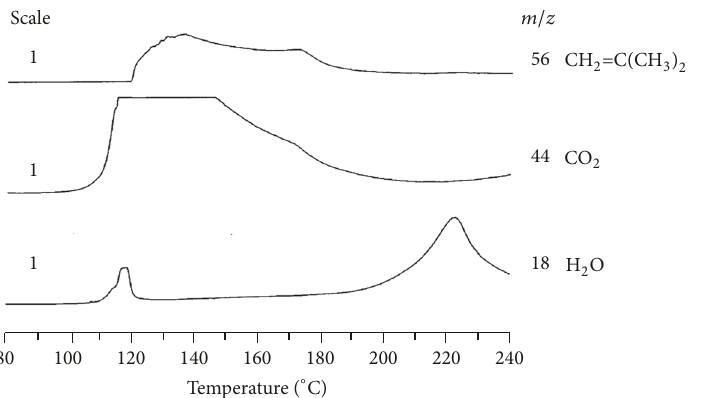
Figure 6: Thermal release patterns of ions for compounds from Boc-L-Asp ( 5a ) by DTA/TG-MS analysis. Ion source: EI, 70eV; temperature: 250 ∘ C. Detection: EI range, 𝑚/𝑧 = 17 to 100; interval, 1.5sec; gain, 2.5. Pipe heater: 280 ∘ C. GC oven: 150 ∘ C; injection: 200 ∘